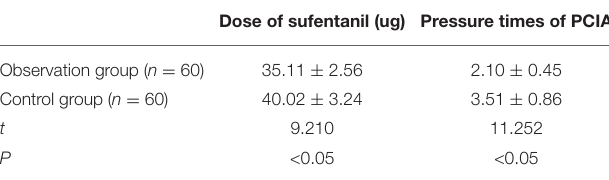
TABLE 2 | Analgesia-related indicators of patients ( x ±